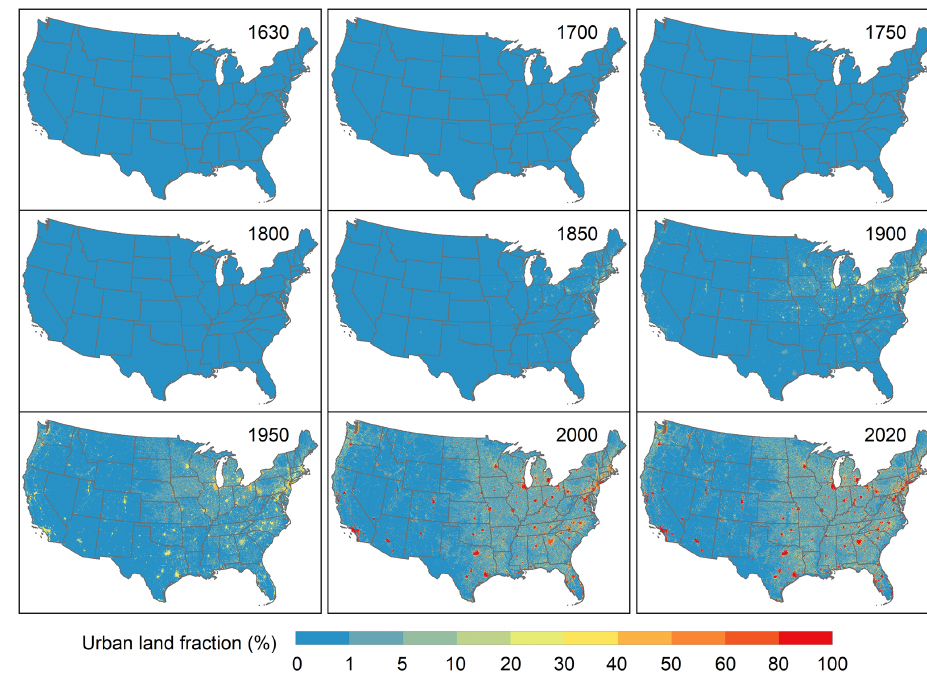
Figure A2. Fractional area of urban land in the conterminous United States during 1630–2020.